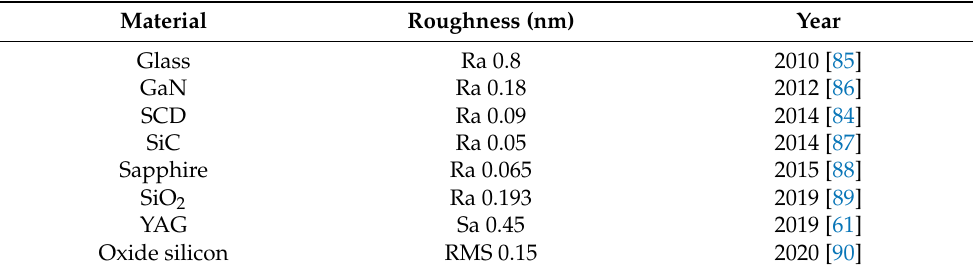
Table 1. The ultimate roughness achieved with CMP for different materials.